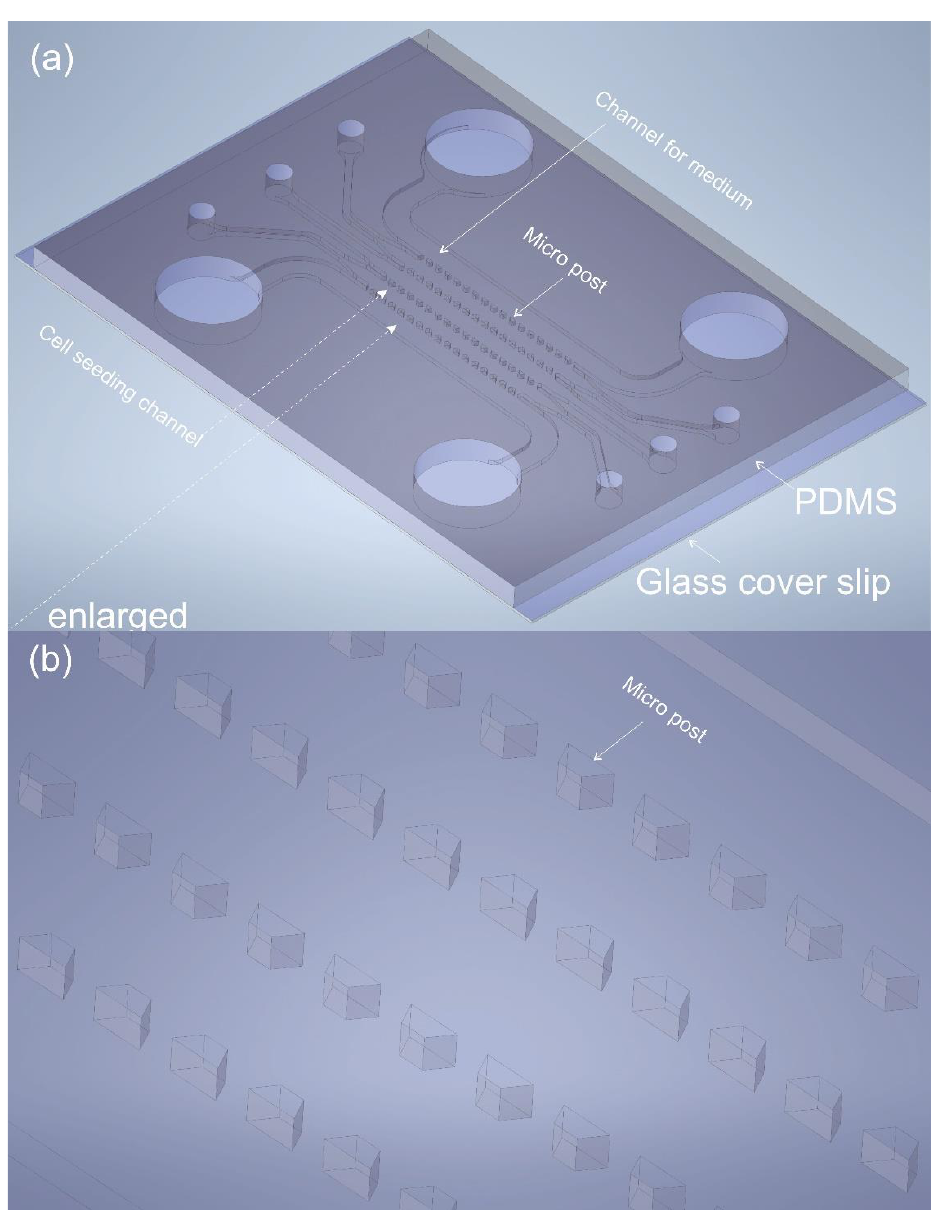
Figure 1. ( a ) 3D illustration of a typical tissue chip made of PDMS (bonded to a glass coverslip). Each main microchannel used for cell culture comprises two parallel rows of micro trapezoidal posts. Trapezoidal posts have been used in many publications including ours [4] and others [8,14]. ( b ) An enlargement view at the micro-post position in the chip shown in Figure 1a.